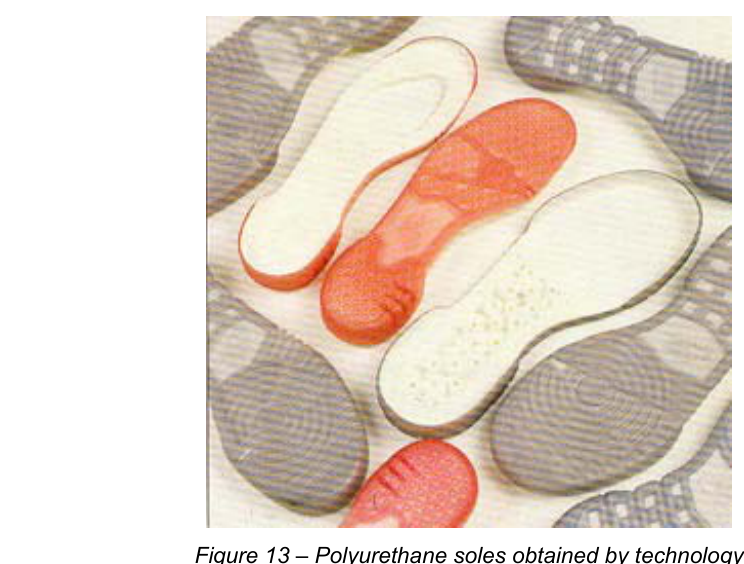
12– Removing the sole from the tool Рис . 12 – Извлечение подошвы из формы Слика 12 – Вађење ђона из алата